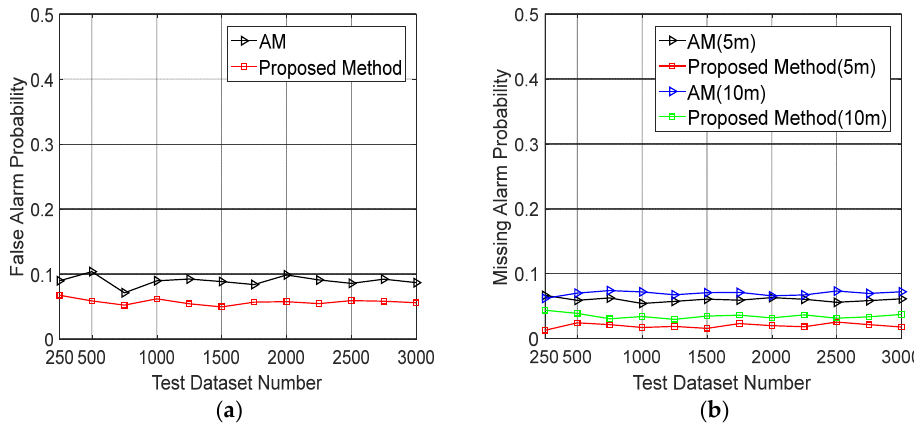
Figure 18. ( a ) The false alarm probability with different numbers of indoor datasets, and ( b ) the missing alarm probability with different numbers of indoor datasets and two distances.